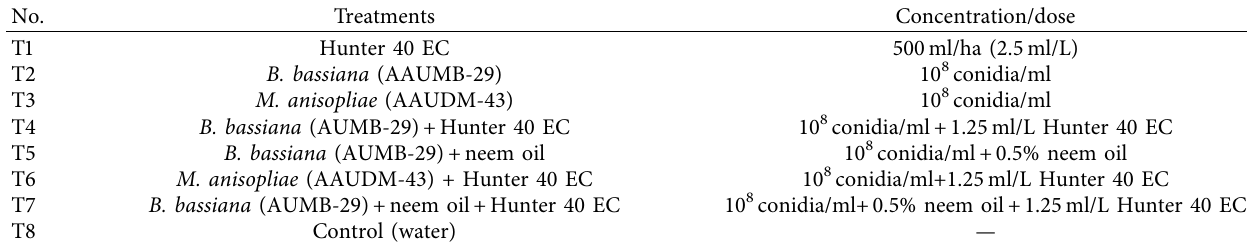
Table 1: Treatments of biopesticides and their dose of field applications.